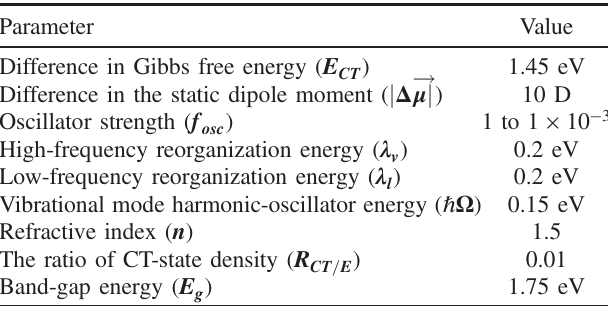
TABLE I. Parameter values used to model the experimental